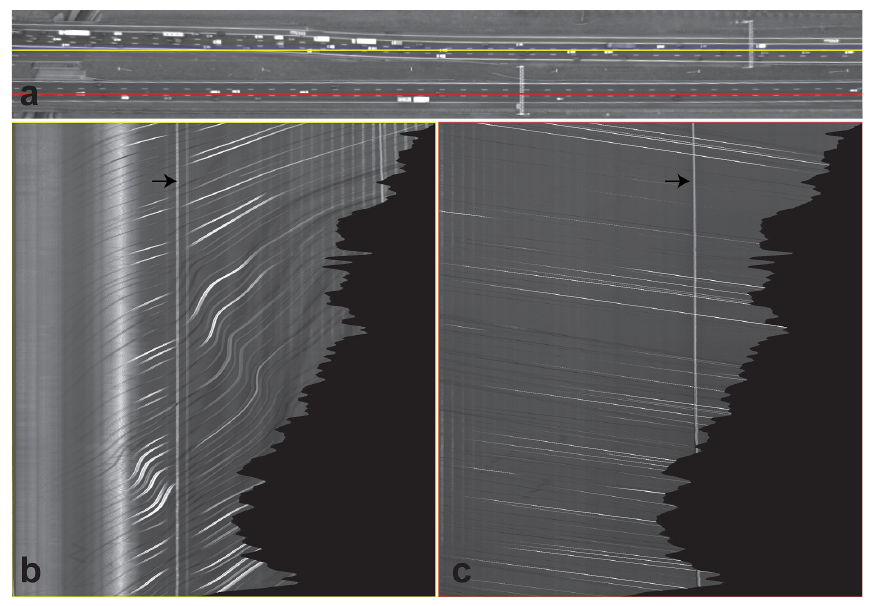
Figure 6. A spatio-temporal image. ( a ) One image from the image sequence. The x-axis is chosen, such that it is parallel to the road line direction of the lowest road line presented in red and top road in yellow. ( b , c ) Spatio-temporal images showing the pixels on the red and yellow lines at the location indicated in the top image as a function of time. The x- and y-axis of this image are, respectively, the image line direction and the temporal direction. The time is increasing downwards. The gantries’ locations are indicated in (a) and (b) by